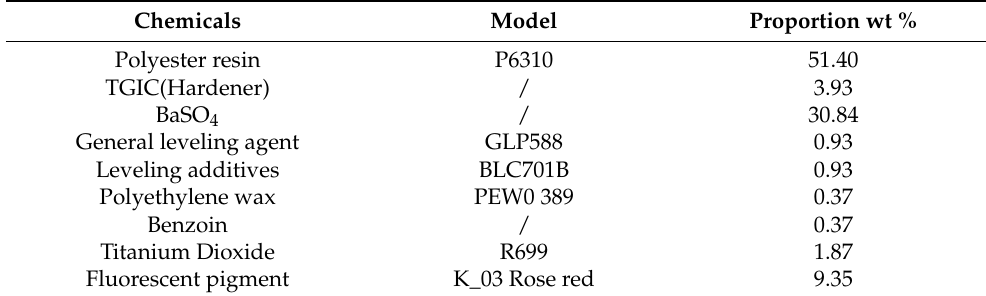
Table 2. Fluorescent powder coating